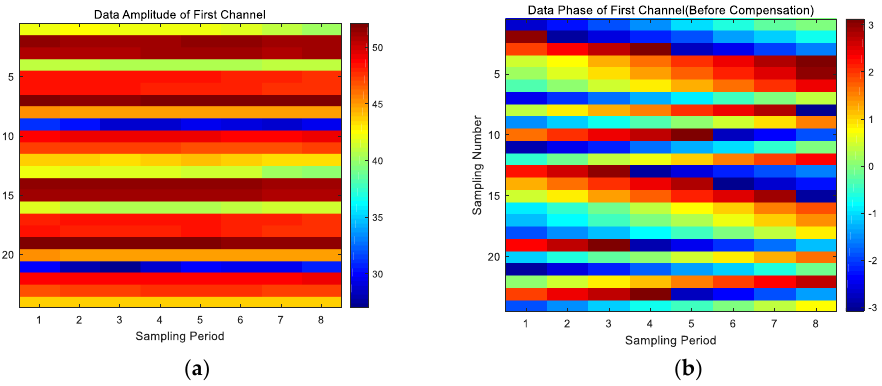
Figure 5. Amplitude and phase of the single–frame data. ( a ) Amplitude. ( b ) Phase.